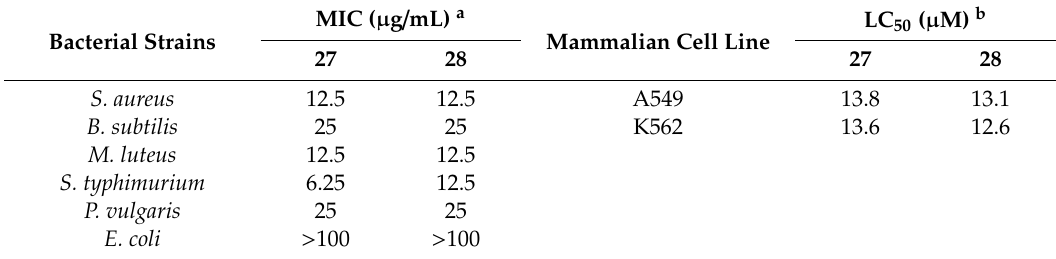
Table 1. Minimum inhibitory concentration (MIC) values expressed in µ g / mL of pseudoaminols A ( 27 ) and B ( 28 ) against bacteria and human cancer cell lines.